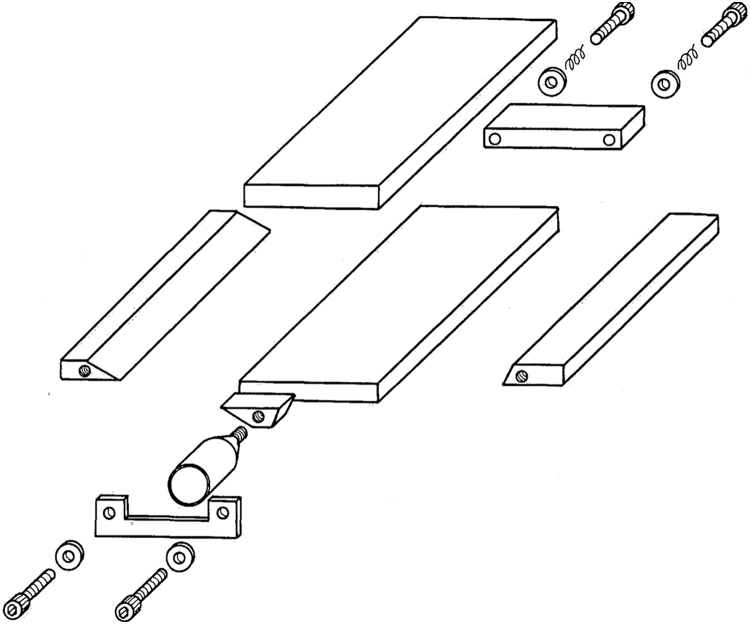
Exploded view of the casting mold of the naphthalene plates [16].